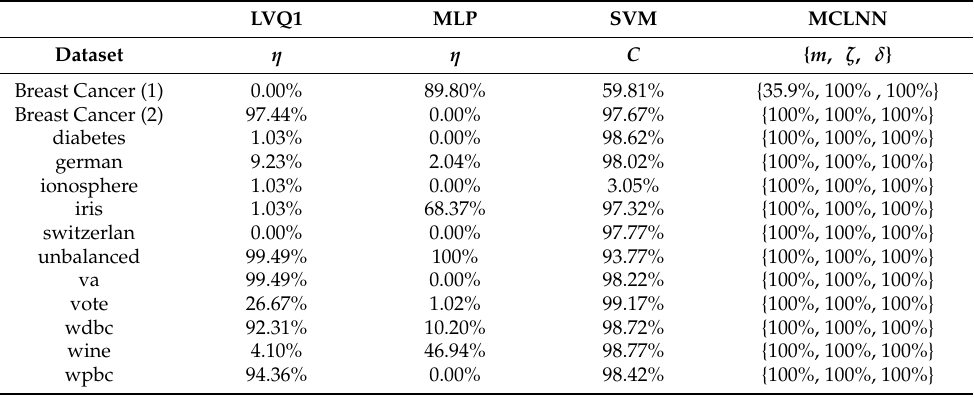
Table 9. Results of the study of the ease of finding satisfactory parameters for the MCLNN train- ing